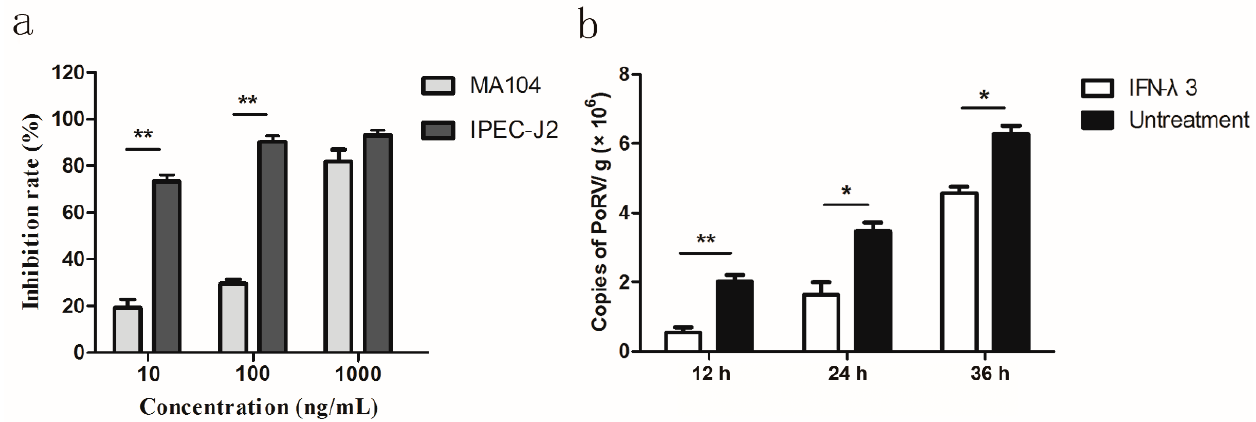
Figure 1. Porcine IFN- λ 3 inhibited PoRV infection in MA104 cells and IPEC-J2 cells. ( a ) MA104 cells and IPEC-J2 cells were stimulated with porcine IFN- λ 3 at different concentrations for 24 h and then infected with PoRV at 0.1 MOI for 36 h. ( b ) IPEC-J2 cells were treated or untreated with 100 ng/mL of IFN- λ 3 for 24 h and then infected with PoRV at 0.1 MOI for 12, 24 or 36 h, respectively. PoRV VP6 mRNA was detected by an RT-PCR. Data were presented as mean ± SEM ( n = 3). * p < 0.05; ** p < 0.01 by t test.